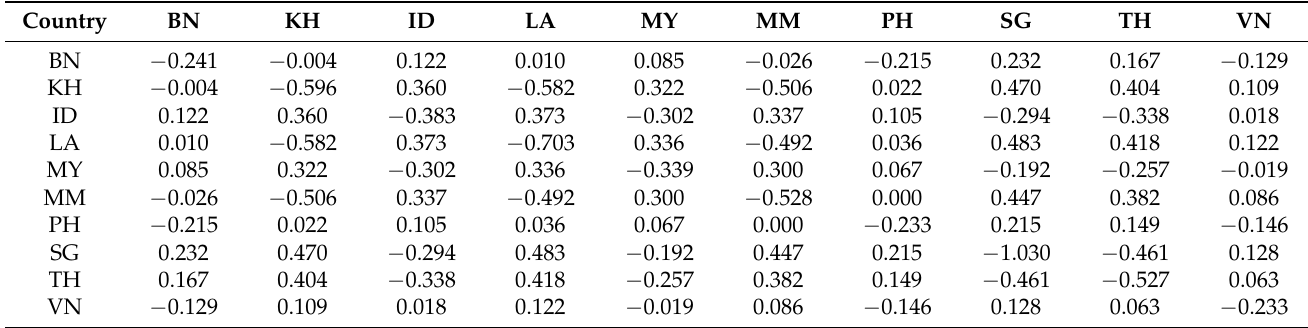
Table A2. The double-centering matrix of alternative according to indicator